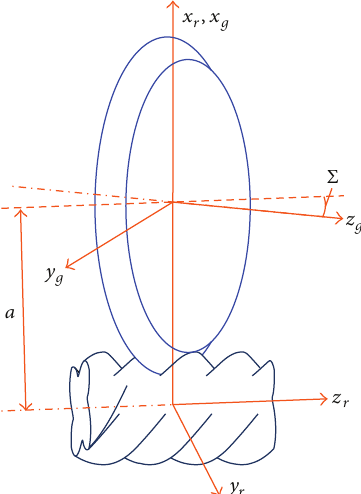
Figure 1: Coordinate system of forming tool for machining screw